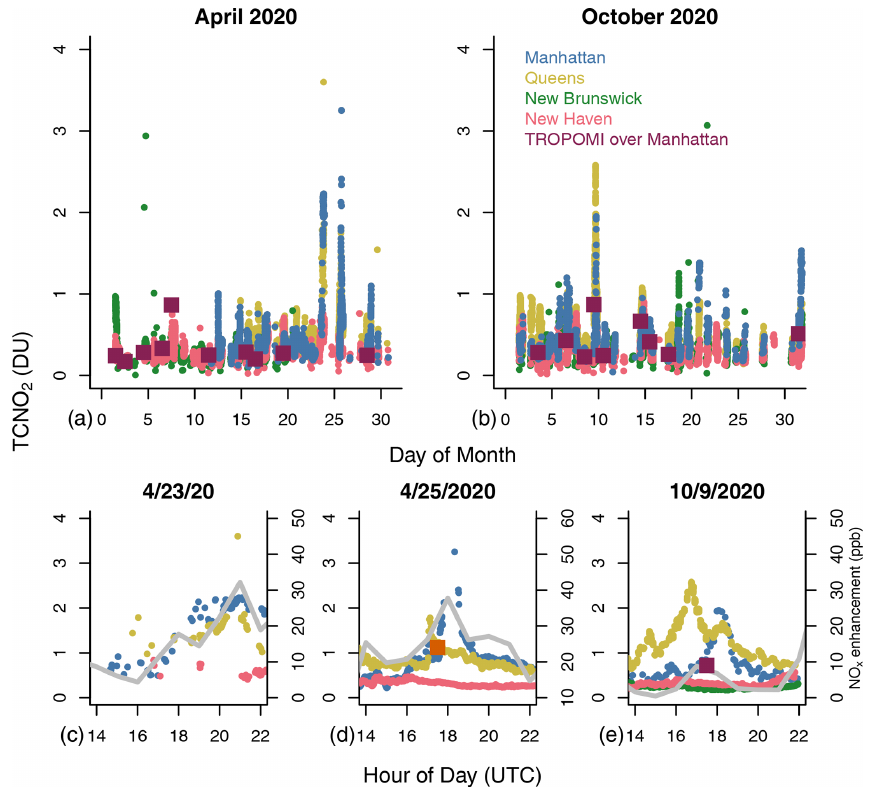
Figure 8. Despite the decline in traffic and physical distancing restrictions, cases of high NO 2 pollution (TCNO 2 > 1.8DU) were observed in the New York metropolitan area during and post the COVID-19 lockdown. TCNO 2 measurements are shown here for (a) April 2020 and (b) October 2020, from Pandora systems in Manhattan, Queens, New Brunswick, and New Haven, and TROPOMI over Manhattan. Diurnal dynamics in TCNO 2 during specific days of exceedances are shown for (c) 23 April, (d) 25 April (square indicates OMI TCNO 2 over Manhattan), and (e) 9 October 2020. The EDGAR power-sector near-surface NO x concentration enhancements in Manhattan are shown by the gray line in (c) – (e)